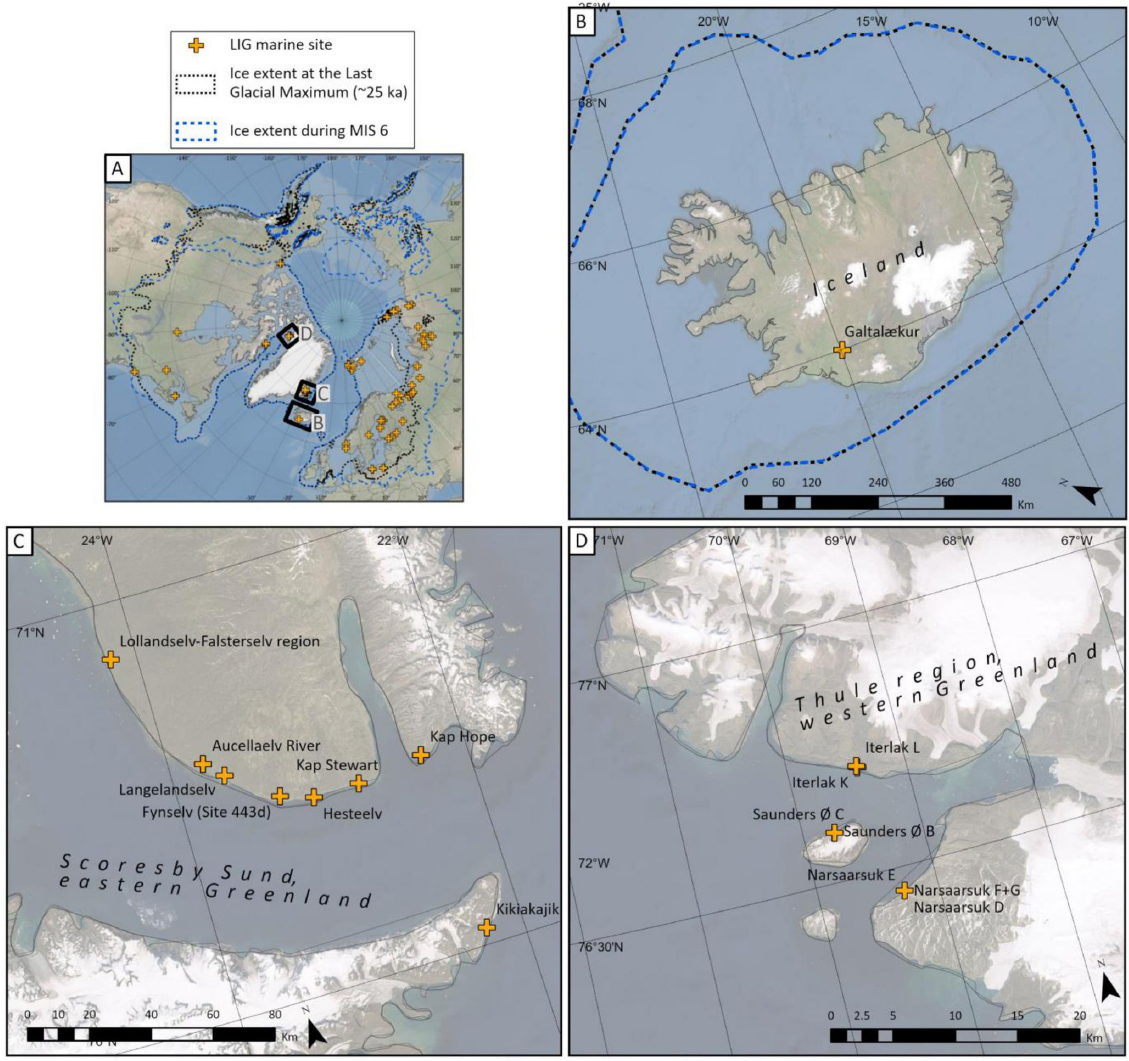
Figure 13. The locations of LIG marine sites in Iceland and Greenland. Panel (a) situates the sites in the Northern Hemisphere, whereas panels (b) , (c) and (d) provide regional maps. Sites plotted on this map are detailed in Sect. 6.40–6.42. Extent of MIS 6 and Last Glacial Maximum ice sheets after Batchelor et al. (2019). Scale calculated at centre of mapped area. Base layer: ArcGIS World